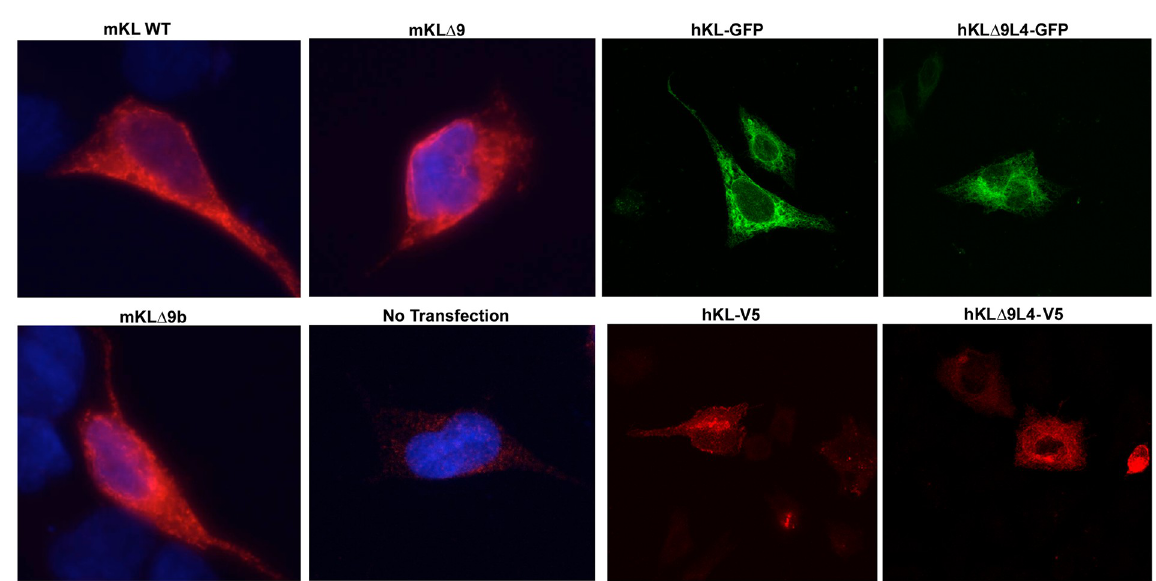
Fig 3. Klotho mutants have similar sub-cellular localization which resembles WT KL distribution. Indirect immunofluorescence shows the sub-cellular localization of Klotho mutants compared to WT KL. COS-7 cells were transfected with indicated plasmids for 48 hours, fixed and studied using either anti-KL (KM2076) or anti-V5 antibodies that recognizes the transfected Klotho-V5